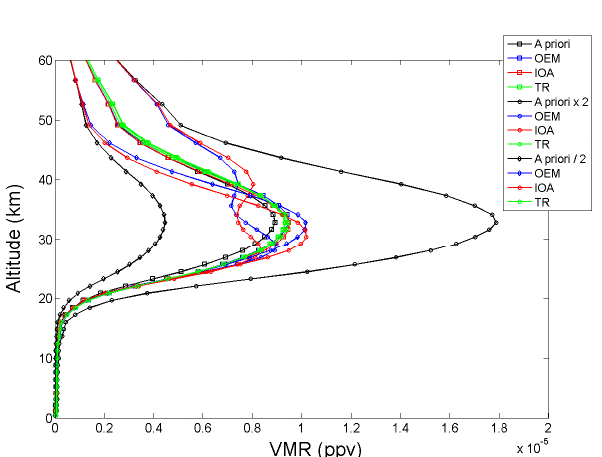
Figure 15. O profile on June 12, 2007 at St.-Denis obtained with the original x Fig. 15. O 3 profile on 12 June 2007 at St.-Denis obtained with 3 the original x a (squares), with 2 x a (circles) and with 1/2 x a (dia- (squares), with 2 x (circles) and with 1/2 x (diamonds), retrieved with the OEM (blue), monds), retrieved with the OEM (blue), IOA (red) and TR (green), a a respectively. The black profiles are the respective a priori IOA (red) and TR (green), respectively. The black profiles are the respective a priori profiles.